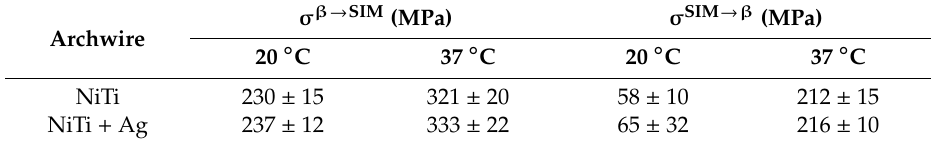
Table 3. Critical stresses for transformation and retransformation at di ff erent test temperatures Archwire